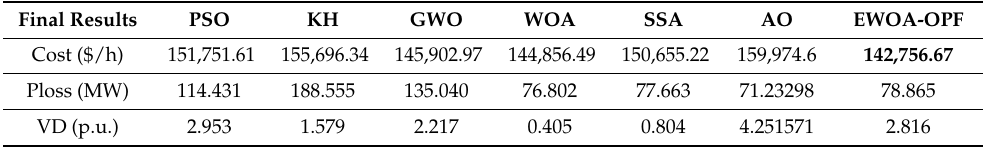
Figure 7. IEEE 118-bus test system single-line diagram. Table 8. Final results of OPF for IEEE 118-bus test system on Case 1.